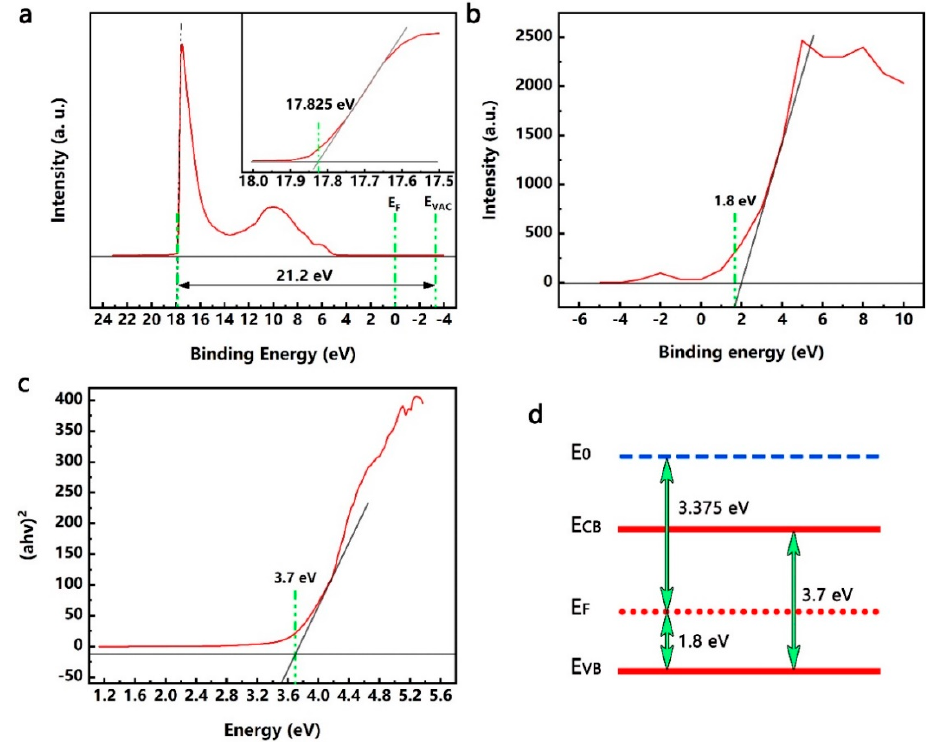
Figure 3. ( a ) The UPS spectra of TiO 2 QDs; ( b ) The XPS spectrum of TiO 2 QDs; ( c ) The plot of ( α h υ ) 2 against photon energy (h υ ) for TiO 2 QDs; ( d ) The corresponding energy band structure of TiO 2 QDs based on the UPS, XPS, and UV-vis results.